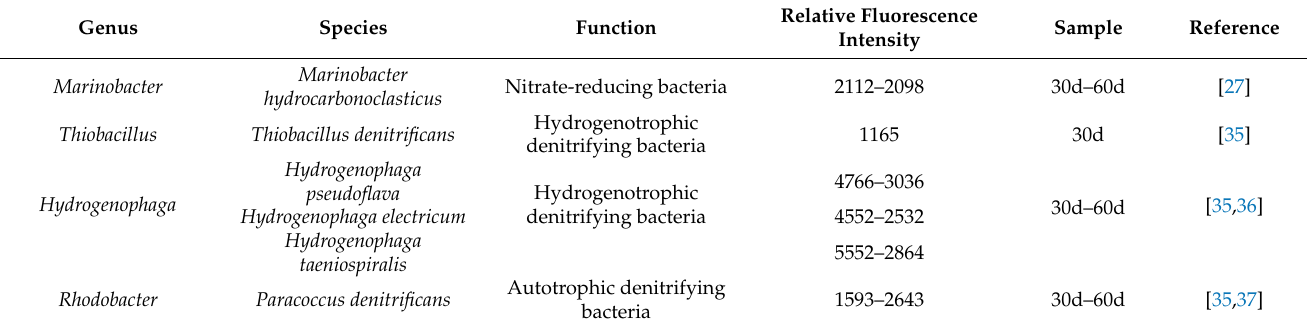
Table 1. Functional microorganisms in MBfRs found in this study.